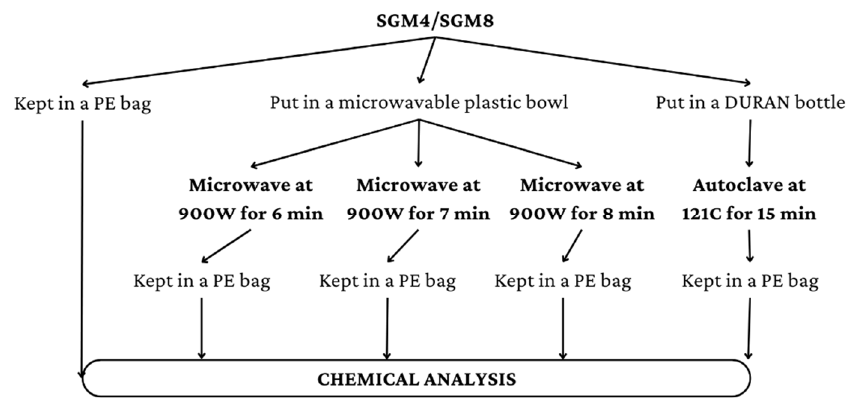
Figure 3. Microwave heating and steaming processes of SGM4 and SGM8 before chemical analysis.